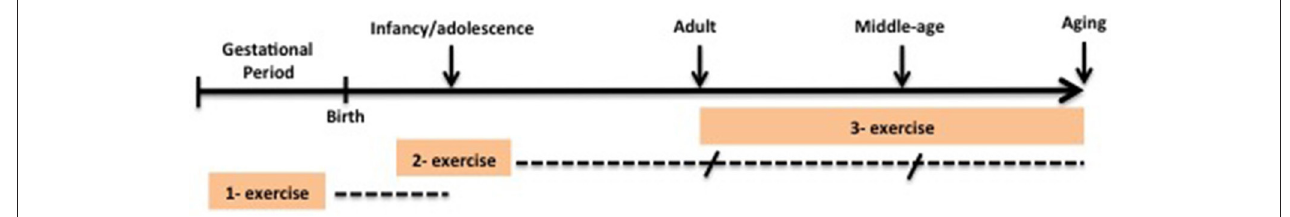
FIGURE 1 | Design of intervention studies on brain resilience in this review. Dotted lines represent follow up outcomes. (1). Exercise during pre-natal period and its effect on brain offspring (infancy and adolescence). (2) Exercise during post-natal brain development (infancy and adolescence) and its effect in later life. (3) Exercise in adulthood, aging and in some-neurologic